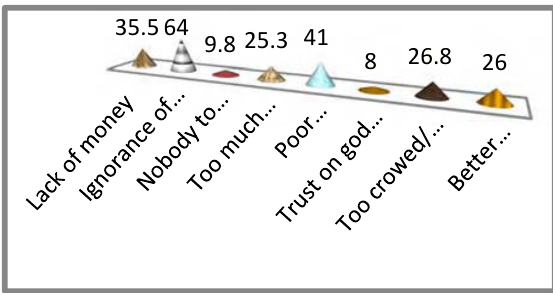
Fig. 1: Percentage distribution of